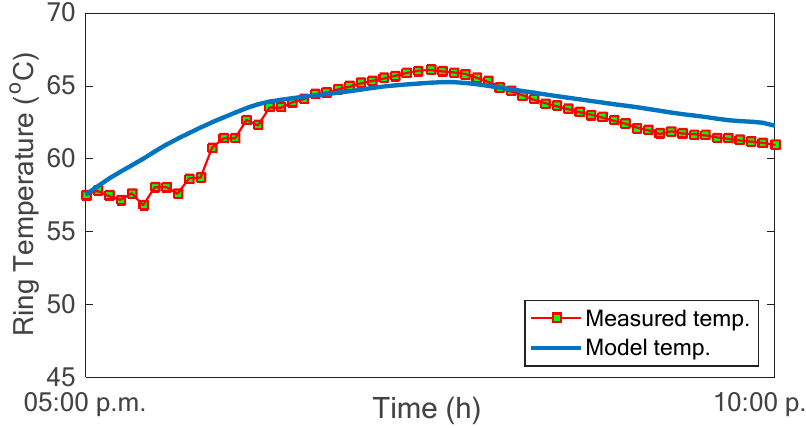
Figure 9. Ring temperature ( V C 0 ) profile: measured data against model results from 5 p.m. to 10 p.m.